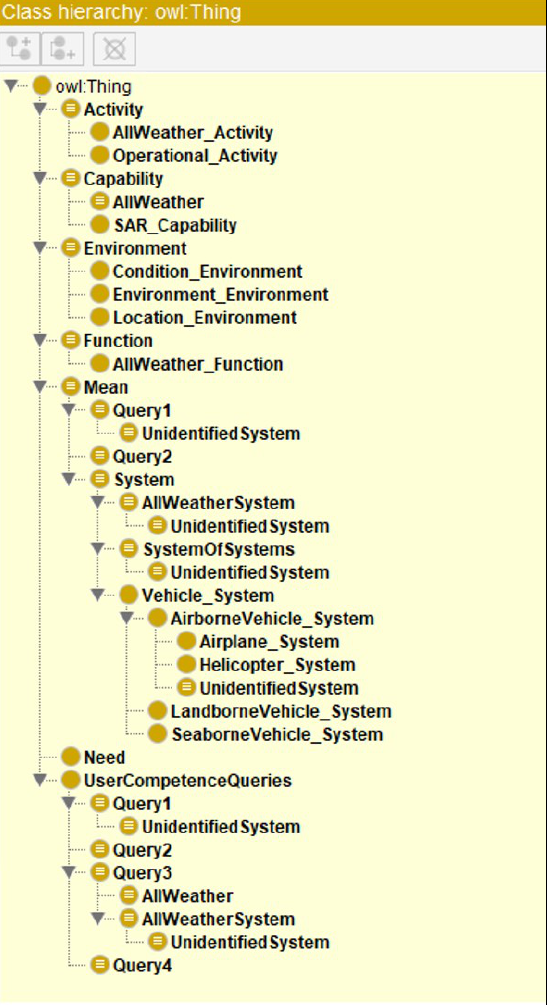
Figure 20. The inferred class hierarchy of the expanded